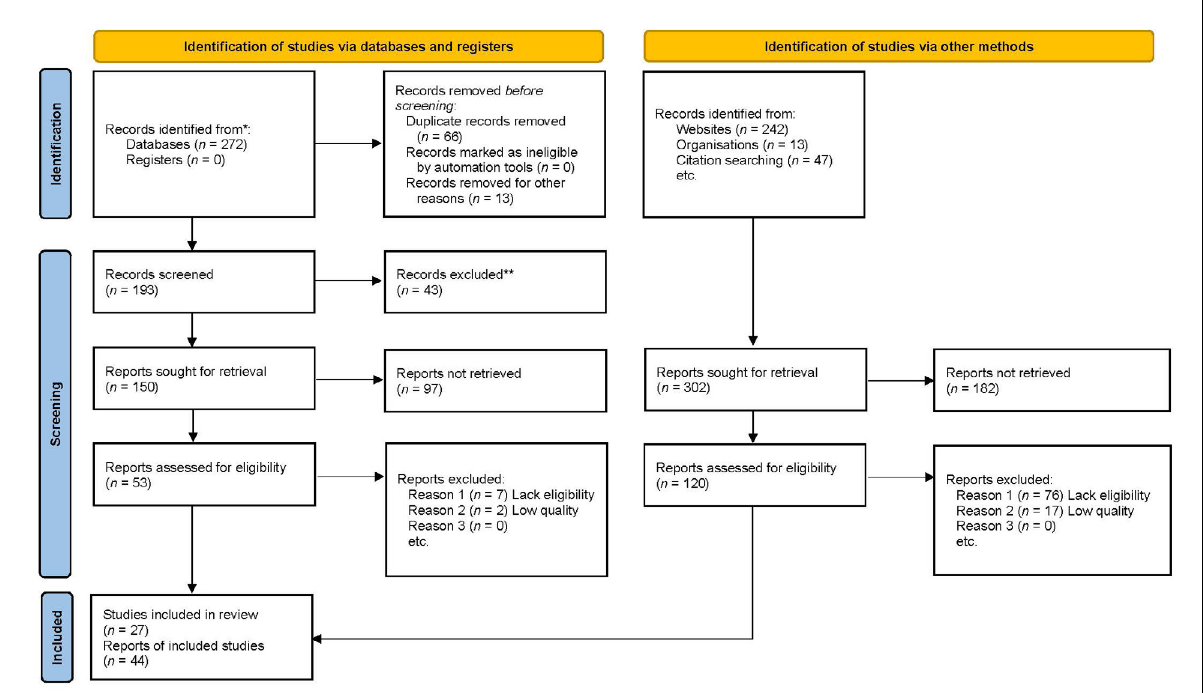
Figure 1: PRISMA diagram on the phytochemicals, bioactivities, and ethnopharmacological uses of selected medicinal